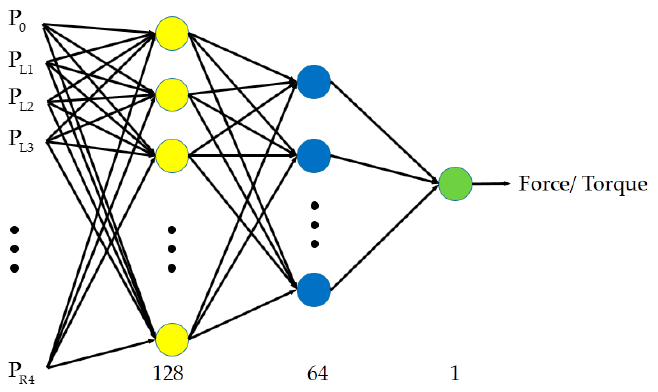
Figure 10. Structure of artificial neural network used.